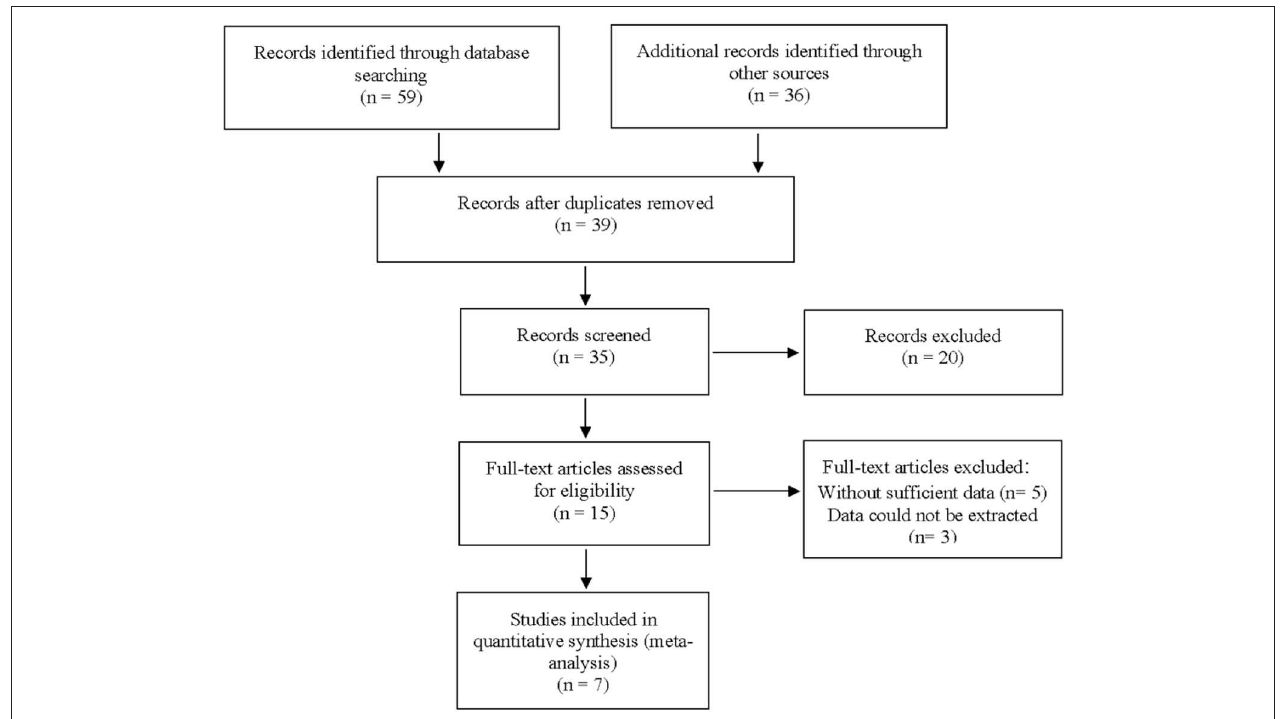
FIGURE 1 | The flowchart for the identification of eligible studies.